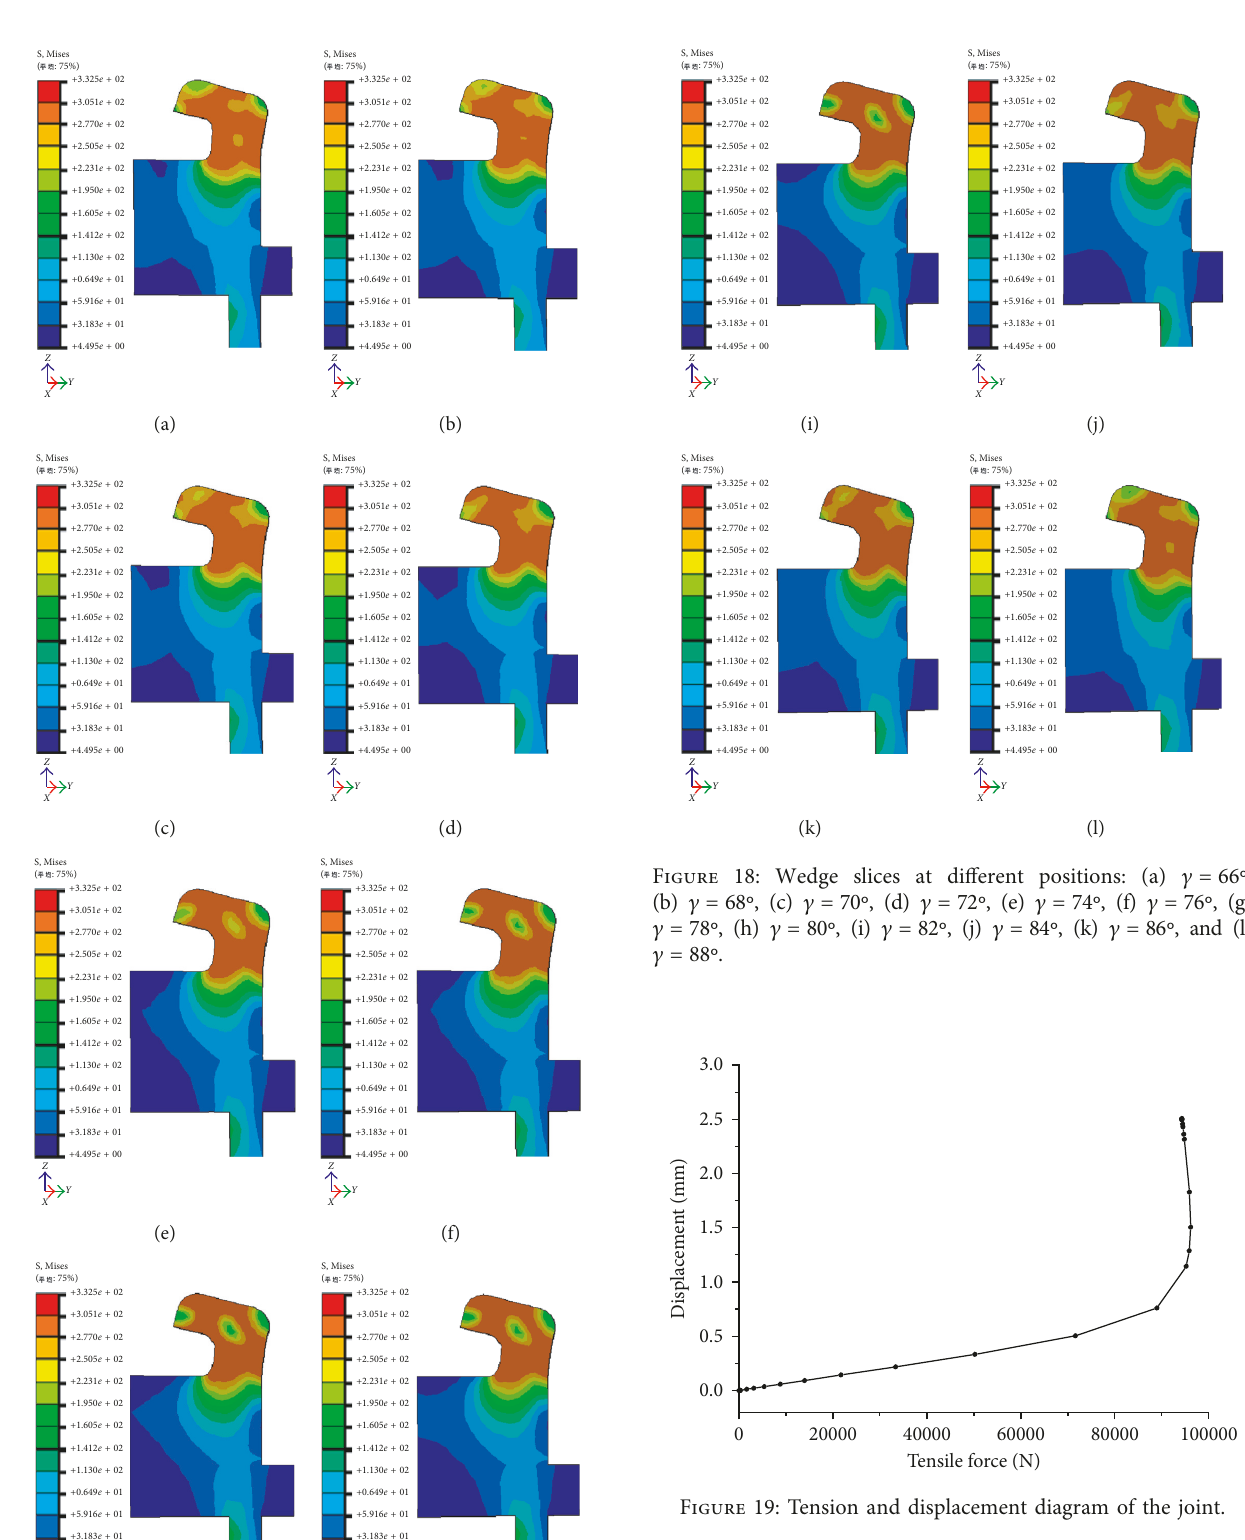
Figure 19: Tension and displacement diagram of the